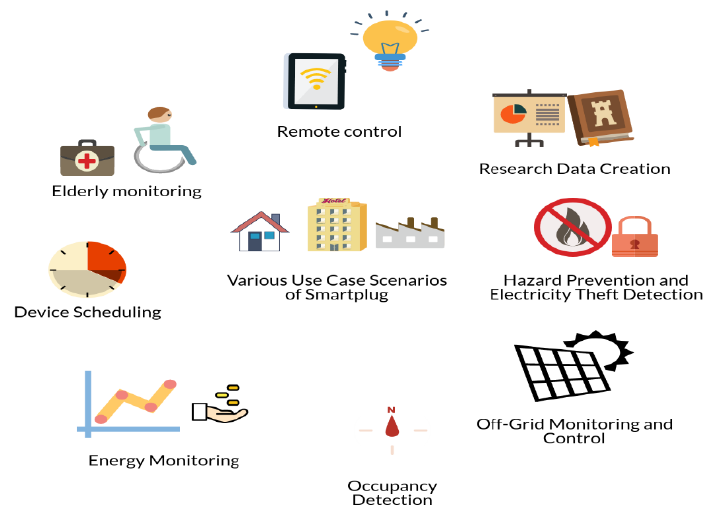
Figure 2. Smart Plug Applications: Present and Future.